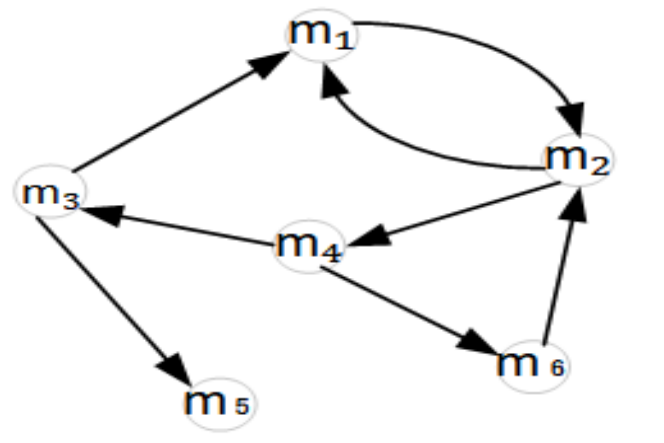
Figure 3. User behavior sequences.